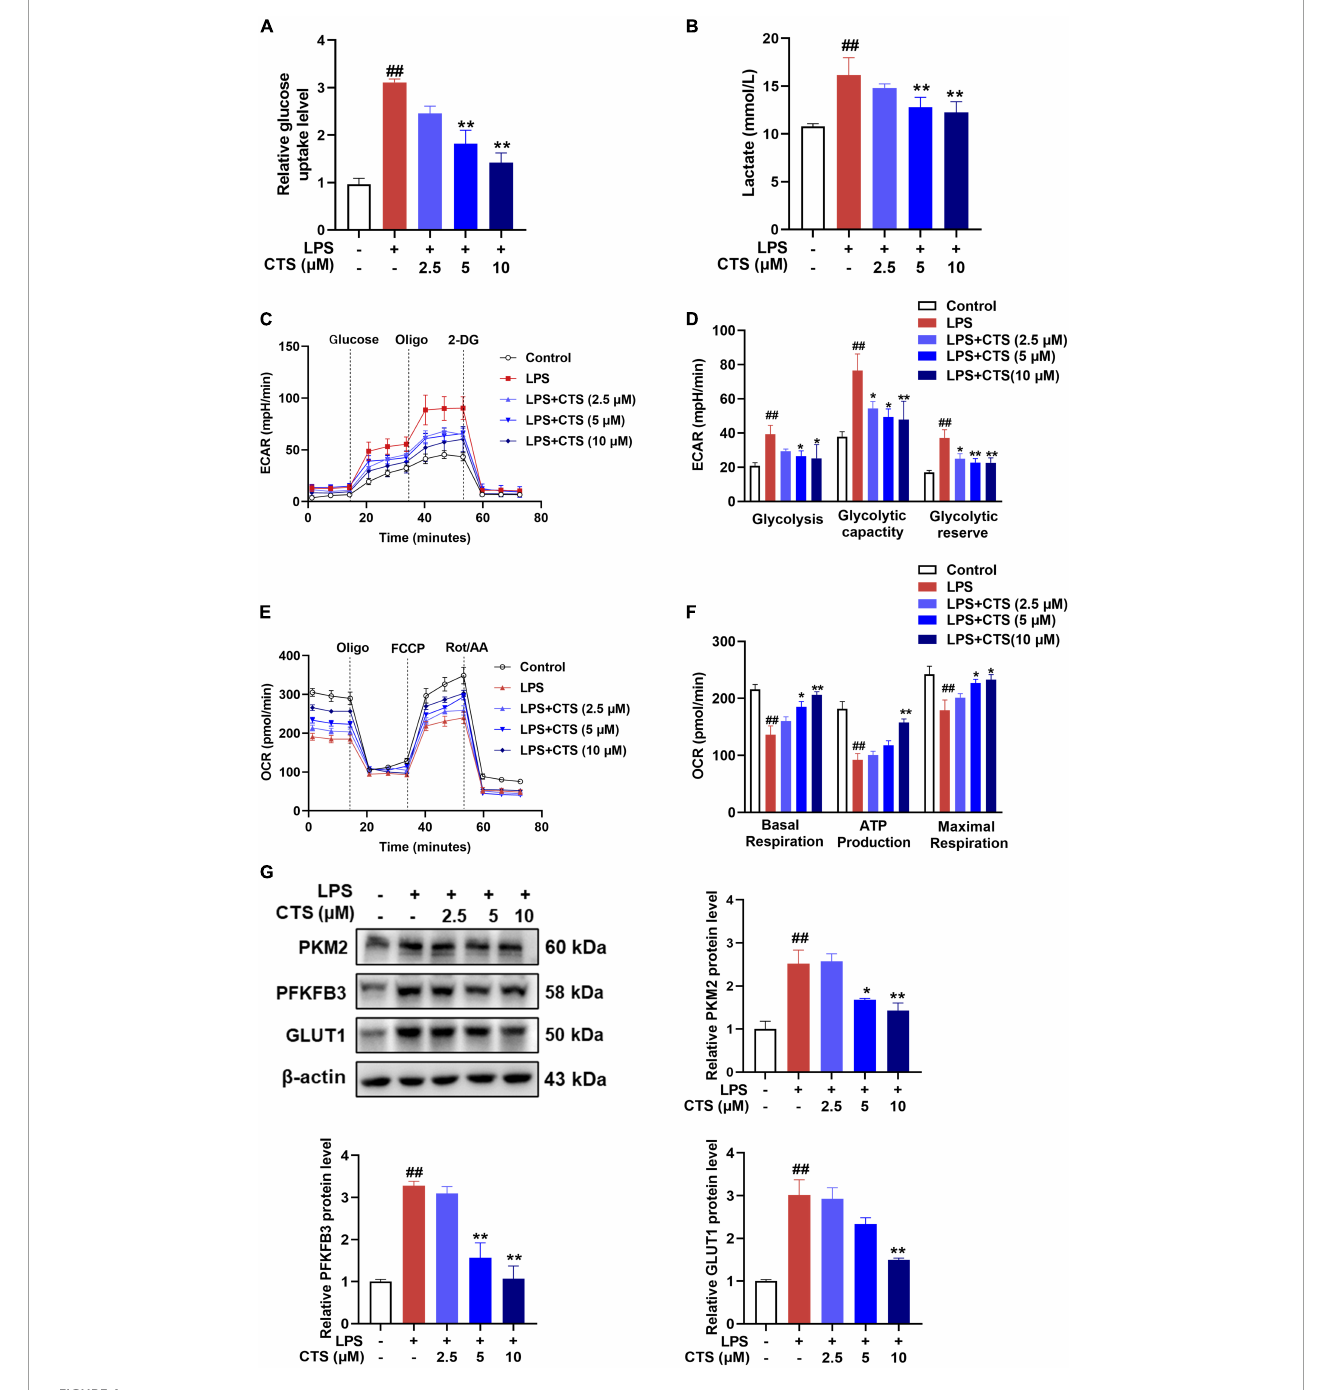
FIGURE4 Cryptotanshinone (CTS) blocks LPS-induced metabolic reprogramming of RAW264.7 macrophages. RAW264.7 were pretreated with CTS (2.5, 5, and 10 µ M) for 2 h and then co-treated with LPS for another 24 h. (A) Glucose uptake was detected using assay kit, n = 4. (B) The level of lactic acid, n = 4. (C,D) The extracellular acidification rate (ECAR) of macrophages were measured, n = 4. (E,F) The oxygen consumption rate (OCR) was measured, n = 4. (G) The protein levels of PKM2, PFKFB3 and GLUT1 were analyzed by using western blotting assay, n = 3. Data were presented as mean ± SEM. ## P < 0.01 vs. the control group; * P < 0.05, ** P < 0.01 vs. the LPS